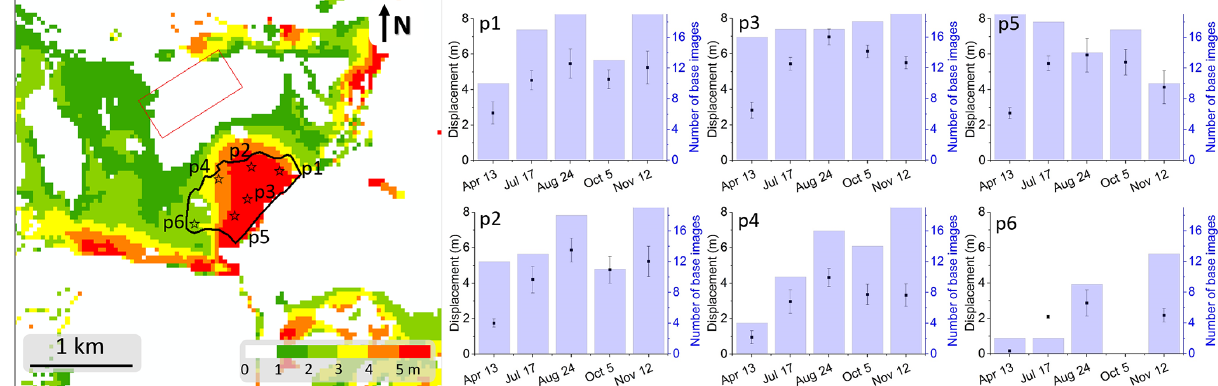
Figure 4. Time series of the slope displacements. Image to the left shows the slope displacements on 12 November 2019, and the map colour is shown as a minimum–maximum linear-stretch type. Sub-panels (p1–p6) to the right show means (points), SDs (vertical bars) and valid numbers (histograms) of cumulative displacements between the 19 base and 5 target images for the six selected points (stars) in the left